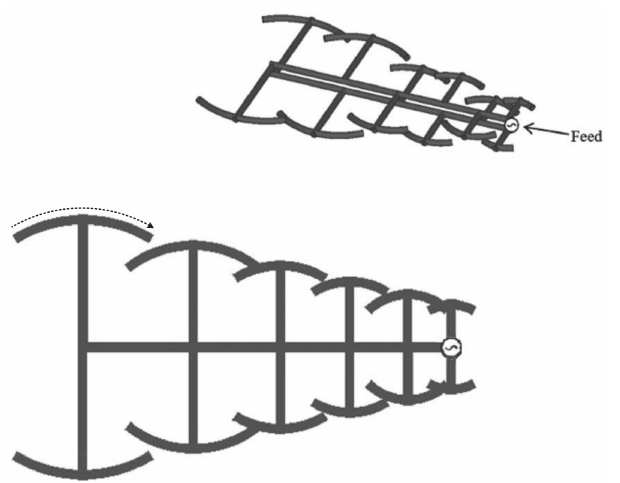
Figure 3. PLPDA design with circular-arc T-shaped loading technique implemented in